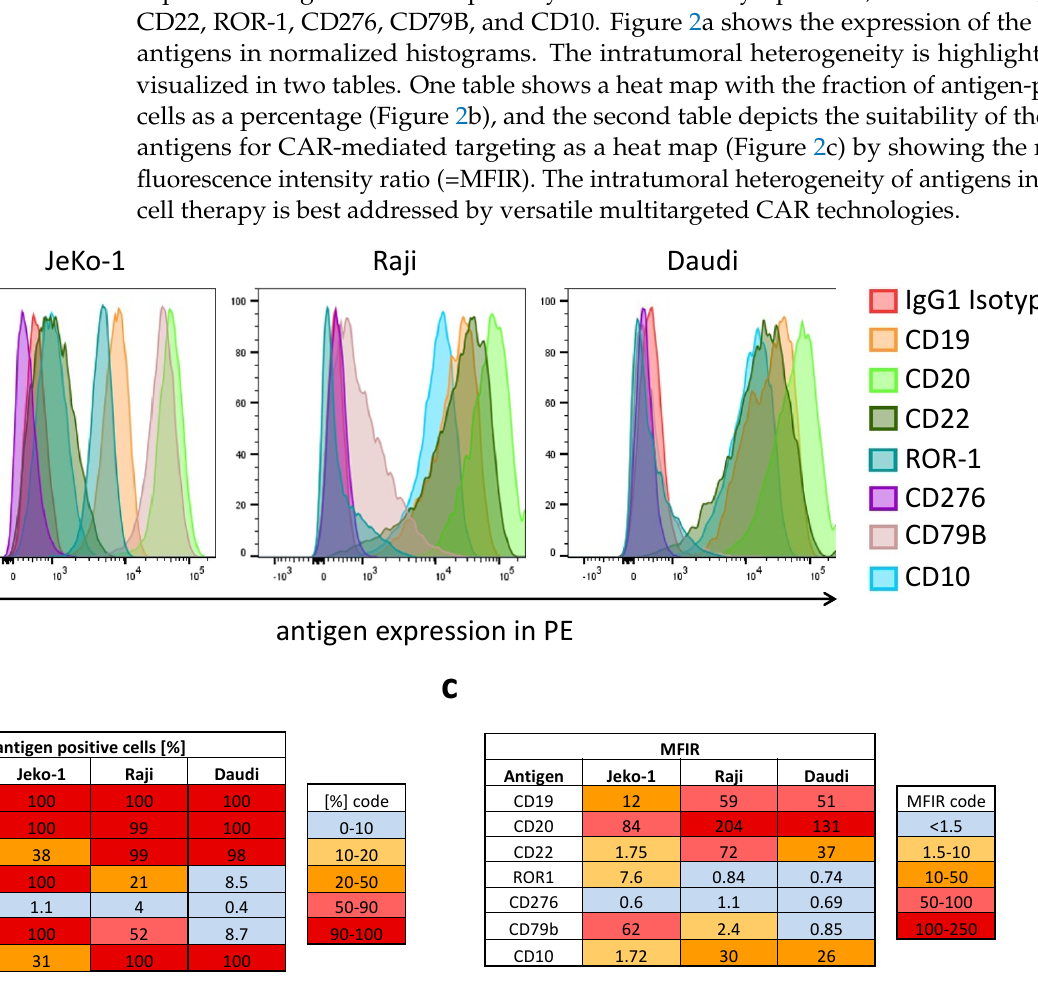
Figure 2. Antigen expression profile of the lymphoma cell lines JeKo-1, Raji, and Daudi. ( a ). JeKo (left), Raji (middle), and Daudi (right) were investigated for the surface expression of the target antigens CD19, CD20, CD22, ROR-1, CD276, CD79B, and CD10. ( b ) The fraction of antigen-positive cells (as a percentage) was calculated by Overton subtraction of the histograms. The table shows the percentage of corresponding antigen positive cells. The sample data minus the corresponding isotype control are shown in the heat map. ( c ) The relative expression level of the screened antigens is shown in the heat map as an index calculated from the median fluorescence intensity of the sample divided by the median fluorescence intensity of the isotype control, defined as the MFIR.